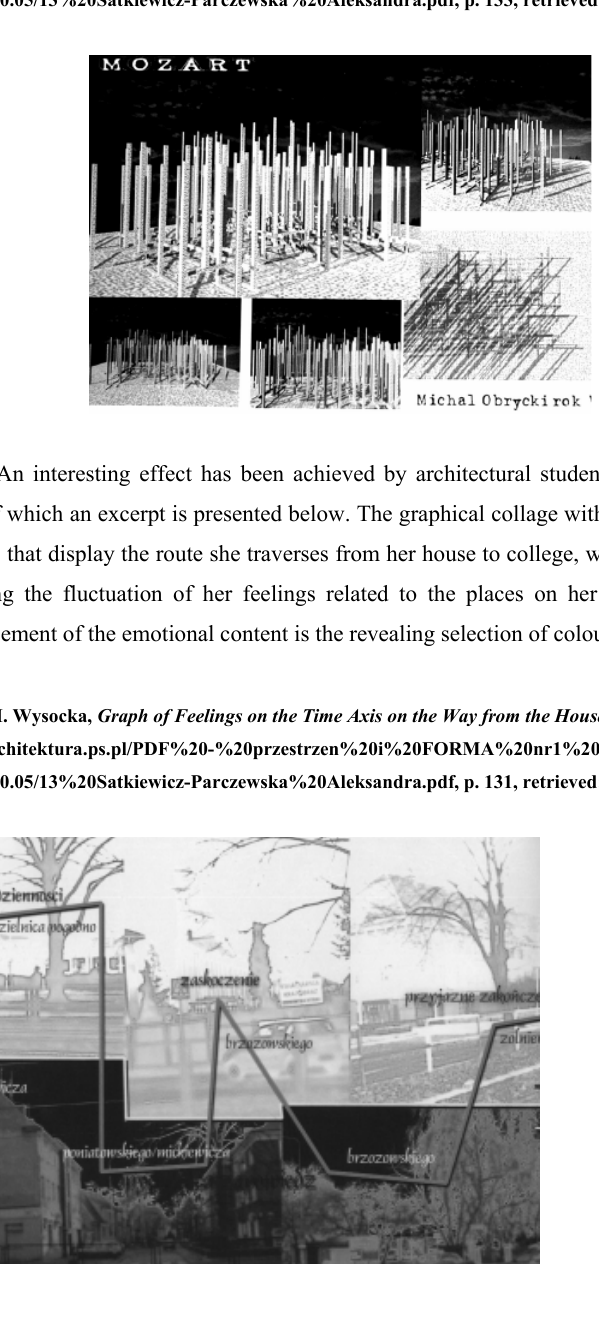
Fig. 3: M. Obrycki, Visualisation of Mozart’s Music , http://architektura.ps.pl/PDF%20-%20przestrzen%20i%20FORMA%20nr1%202005%20- %2011.10.05/13%20Satkiewicz-Parczewska%20Aleksandra.pdf, p. 133, retrieved: 23. 11. 2008